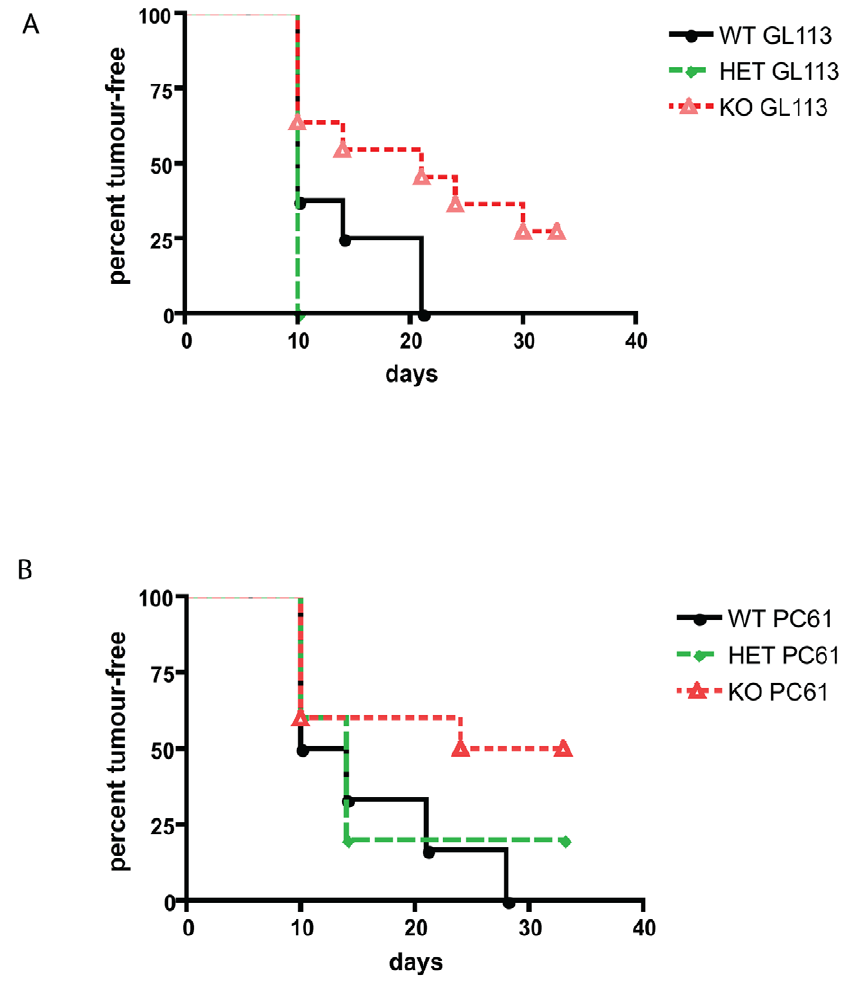
Figure 5. Depletion of regulatory T cells leads to improved tumour rejection in both AIRE 2 / 2 and AIRE + / + mice. Mice of the indicated genotype were primed and challenged with B16F10. Three days and one day prior to challenge, mice were treated twice with 0.5 mg of control antibody GL113 ( A ), or with regulatory T cell-depleting antibody PC61 ( B ). Seven days after depletion with PC61 but not GL113 antibodies, CD4 + CD25 + cells were reduced by 60% in the blood. Appearance of tumours was measured for 121 days.